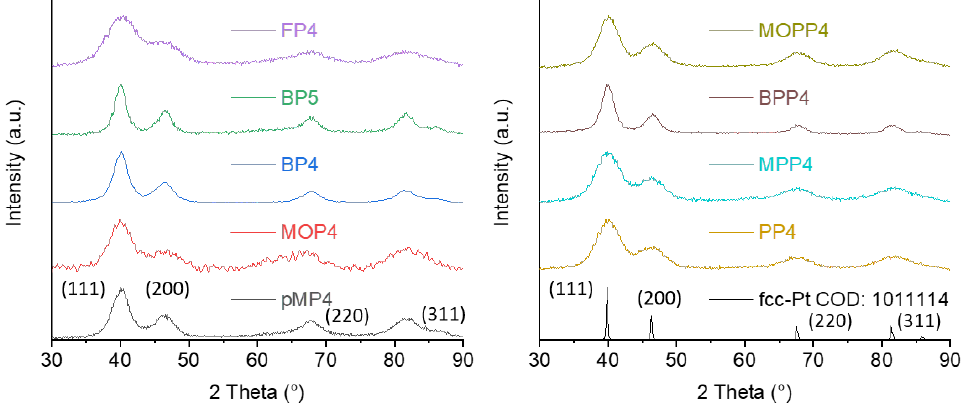
Figure 2. PXRD patterns of synthesized (TAAIL)Pt-NPs (cf. Figure 1 and Table 2). All obtained reflexes match the simulation for face-centered cubic, fcc-Pt with its indexed reflections (Crystallo- graphic open database, COD fcc-Pt: 1011114). Table 2. Summary of crystallite and particle sizes of